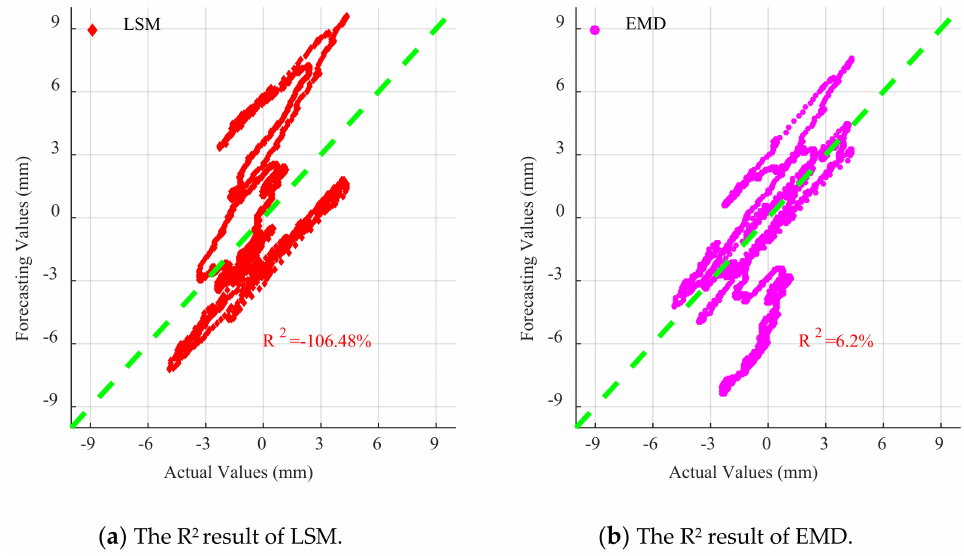
Figure 16. Conts